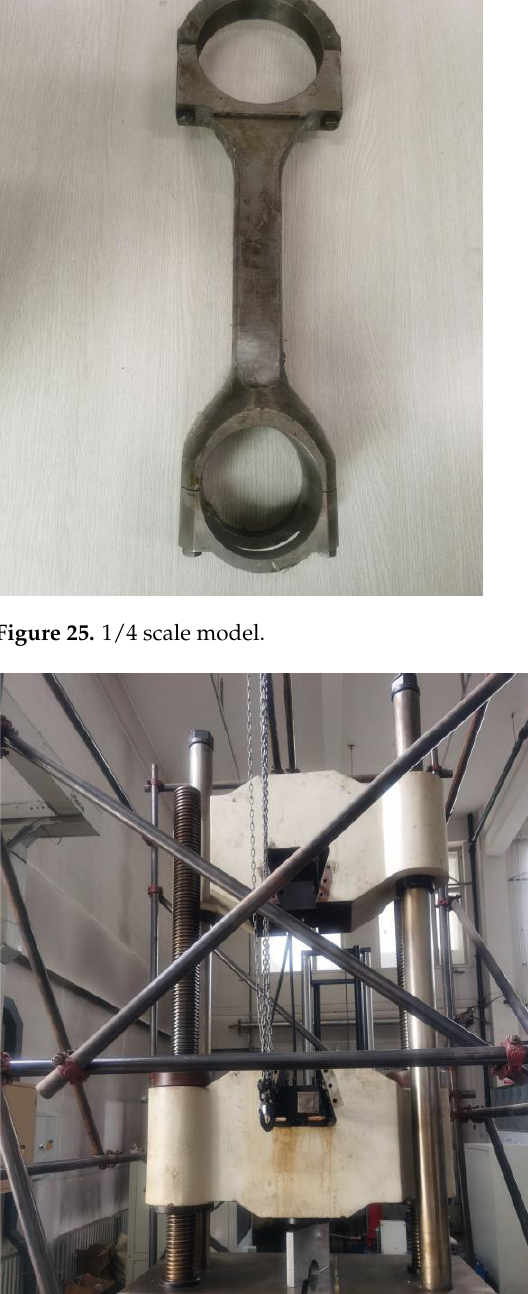
Figure 27. DH5922D dynamic signal tester.